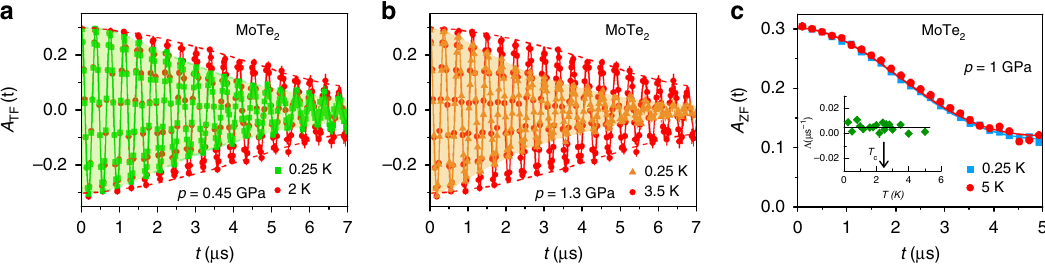
Fig. 2 Transverse- fi eld (TF) and zero- fi eld (ZF) μ SR-time spectra for MoTe 2 . The TF spectra are obtained above and below T c in an applied magnetic fi eld of μ 0 H = 20 mT (after fi eld cooling the sample from above T c ) at p = 0.45 GPa ( a ) and p = 1.3 GPa ( b ). The solid lines in a and b represent fi ts to the data by means of Eq. (1). The dashed lines are guides to the eye. c ZF μ SR time spectra for MoTe 2 recorded above and below T c . The line represents the fi t to the data with a Kubo – Toyabe depolarization function 39 , re fl ecting the fi eld distribution at the muon site created by the nuclear moments. Error bars are the s.e. m. in about 10 6 events. The error of each bin count n is given by the s.d. of n . The errors of each bin in A ( t ) are then calculated by s.e. propagation